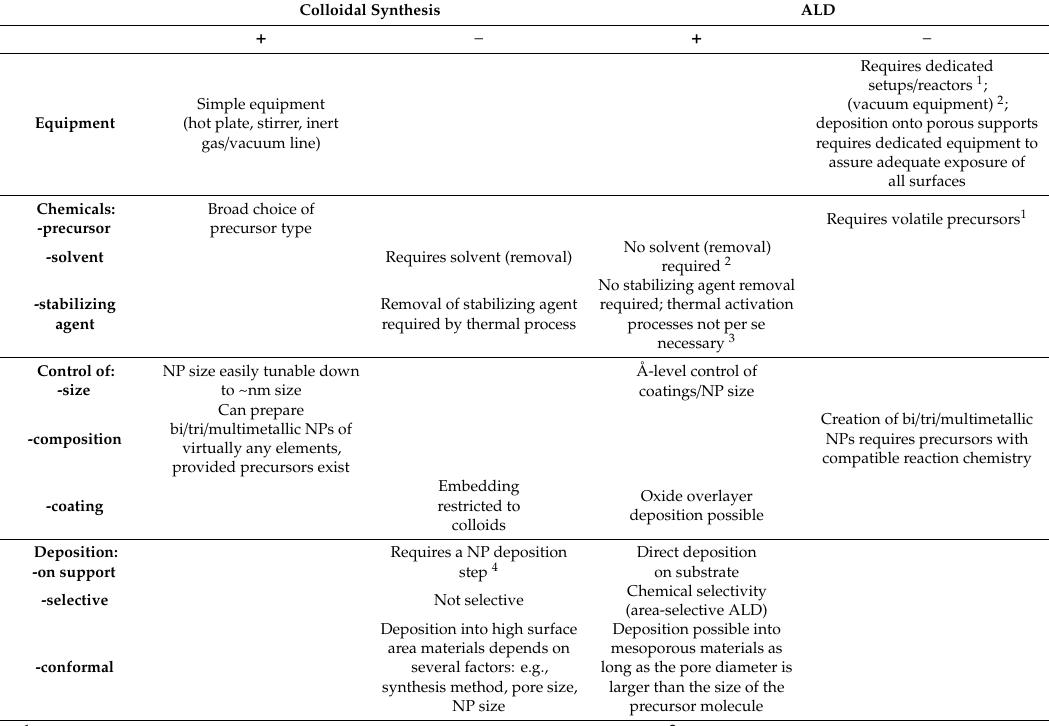
Table 1. Summarized advantages ( + ) and disadvantages ( − ) of colloidal synthesis and ALD for supported catalyst